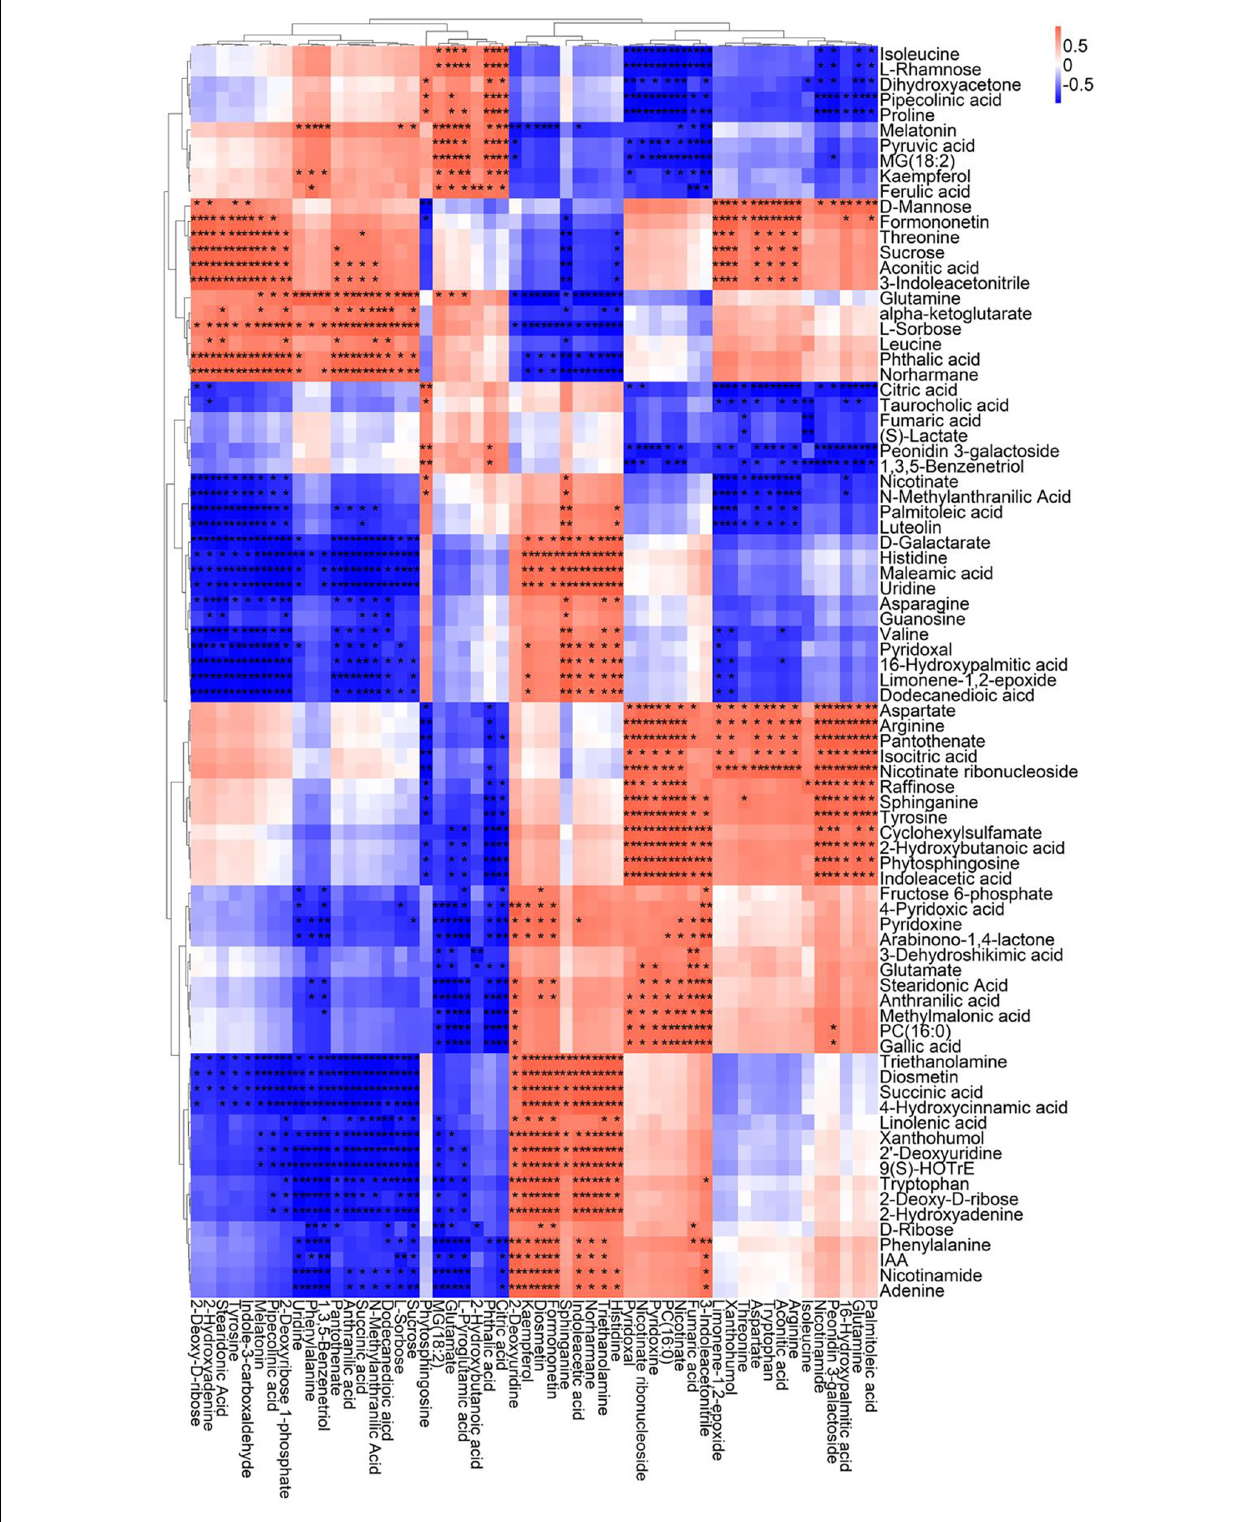
FIGURE 6 | Correlation analysis of TLP-DN3 leaf metabolites subjected to spaceflight treatment. A correlation matrix was generated using Pearson’s correlation on six biological replicates of CK and SP-treated plants. Red color shows positive correlation whereas blue color represents negative correlation among the metabolites under spaceflight treatment. ** and * indicate significant difference at p < 0.01 and p < 0.05 by Pearson’s correlation test, respectively.